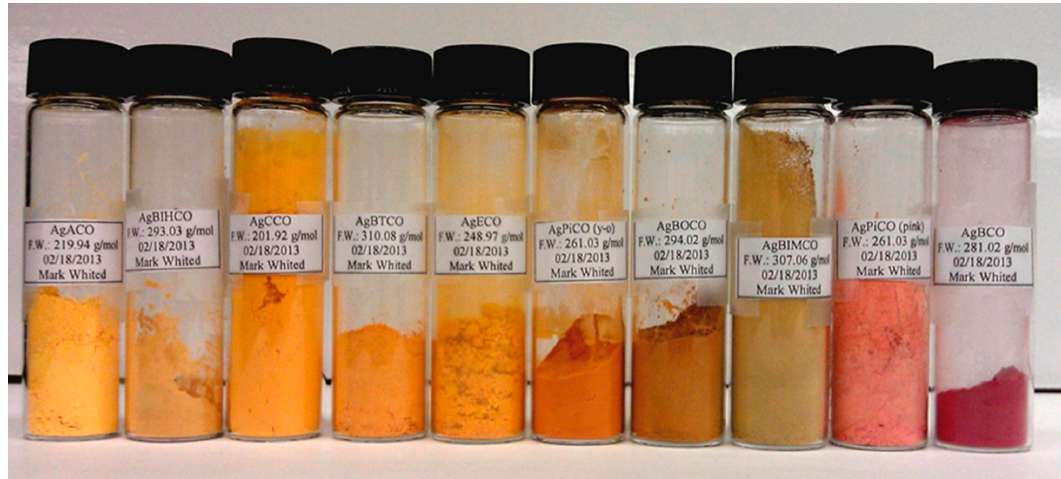
Figure 1. Pyrex vials with visible light insensitive, thermally stable, sparingly water soluble and antimicrobial Silver(I) cyanoximates: demonstration of variety of unusually bright colors of complexes.